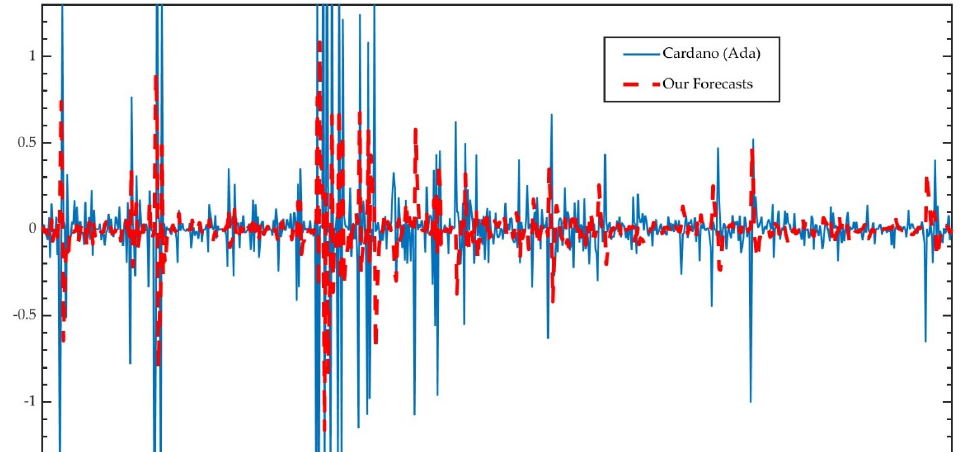
Figure 1. Out-of-sample forecast for ADA.This figure reports the out-of-sample forecasts of Cardano (Ada) using Equation (2) with a rolling scheme and R = 0.5 × T (from 22 January 2020 to 13 April 2022). Source: Authors’ elaboration.